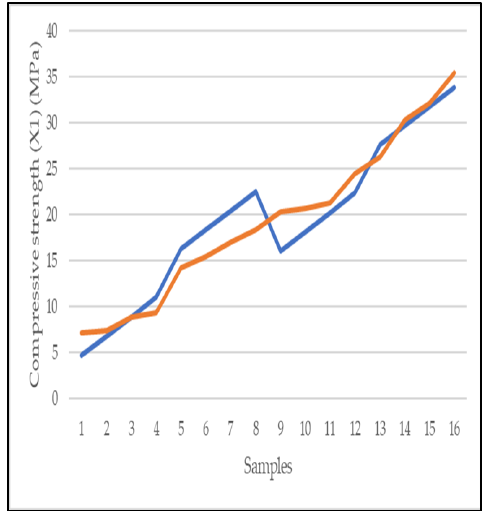
Figure 9. Probability and predicted output of compressive strength. Table 12. Optimal points between compressive and tensile